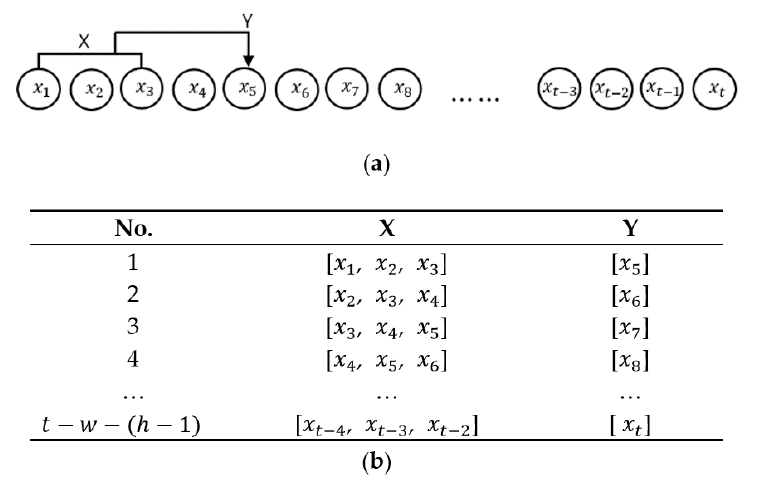
Figure 7. LSTM input data sample creation. ( a ) Data sampling for LSTM input ( 𝑤 = 3, ℎ = 2). ( b )